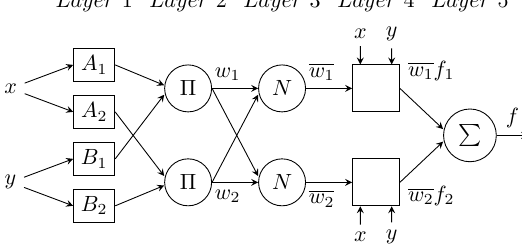
Figure 15. ANFIS architecture schematic with two